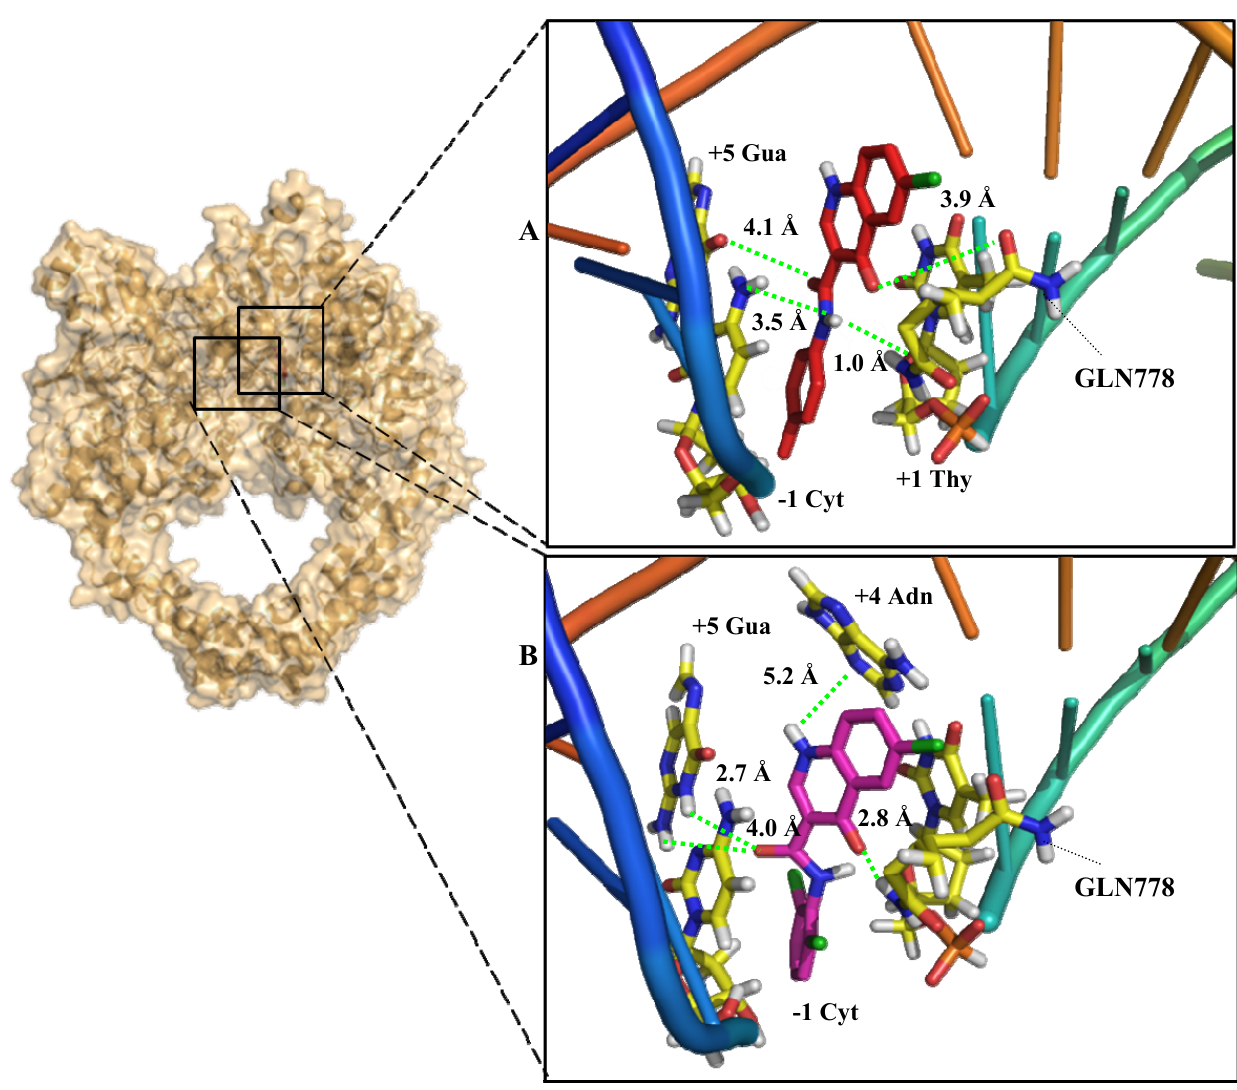
Figure 3. Molecular docking of 16b ( A ) and 17b ( B ) in the topoisomerase II binding site: The cartoon-and-stick representation shows the insertion of 16b (in red) and 17b (in pink) as well as the hydrogen bonds (in green) between the GLN778 residue of the enzyme (in yellow) and the nucleotides(Adn, adenosine; Cyt, cytosine; Thy, thymine; Gua,